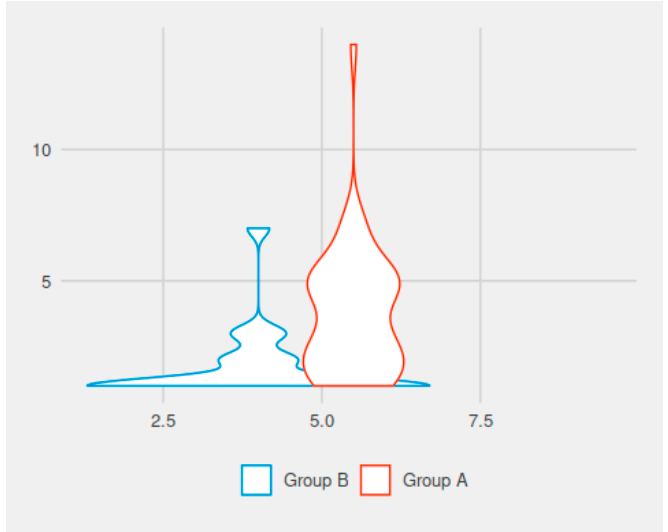
Figure 2. Duration of rhinorrhea and/or nasal obstruction versus velopharyngeal insufficiency with or without electrocautery use (on the vertical line—the duration of rhinorrhea and/or postoperative nasal obstruction in the two groups of children, in days; on the horizontal line—the duration of velopharyngeal insufficiency symptoms in the two groups of enrolled children, in days). In comparing the values for the duration of post-adenoidectomy velopharyngeal insufficiency symptoms (hypernasal speech, in days), there was a statistically significant difference between the groups. The mean duration of velopharyngeal insufficiency was 3.71 days for the patients in group A (electrocautery) and 1.64 days for the patients in group B (no electrocautery). The difference was statistically significant ( p < 0.001) (Figure 2). In comparing the frequency of postoperative malodor (halitosis) encountered in the pa- tients in group A (31 out of 45 patients) to that of the patients in group B (1 out of 45 patients), there was a statistically significant difference between the groups (X-squared = 40.781, df = 1, p < 0.001. Postoperative halitosis was encountered more frequently in the patients in whom electrocautery was used intraoperatively (Figure 3).